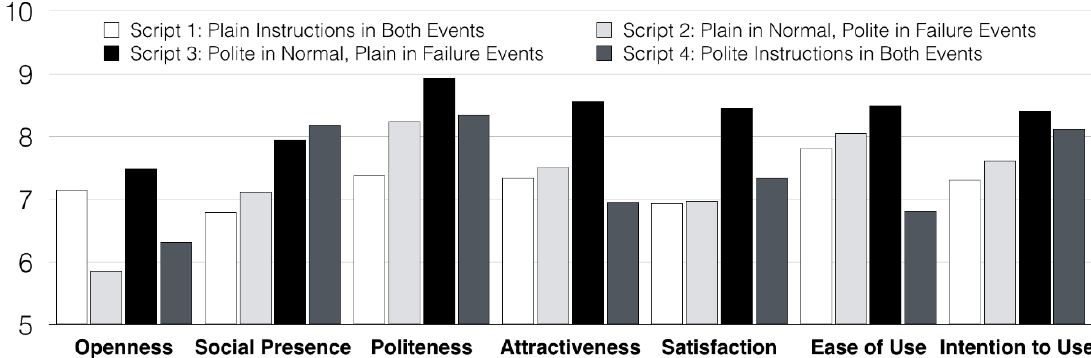
Figure 3. Interaction Experience of Each Instruction Strategy.